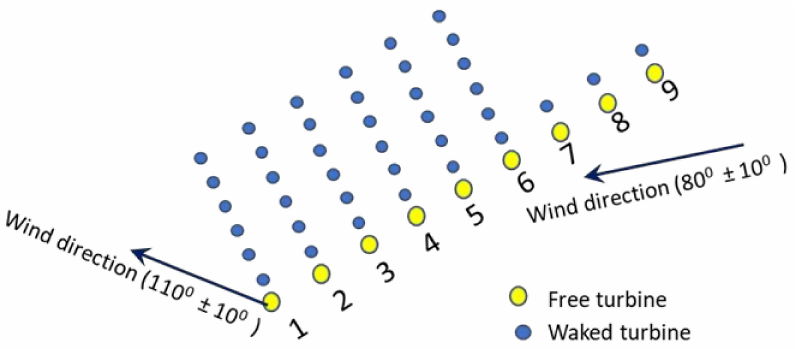
Figure 23. The wind